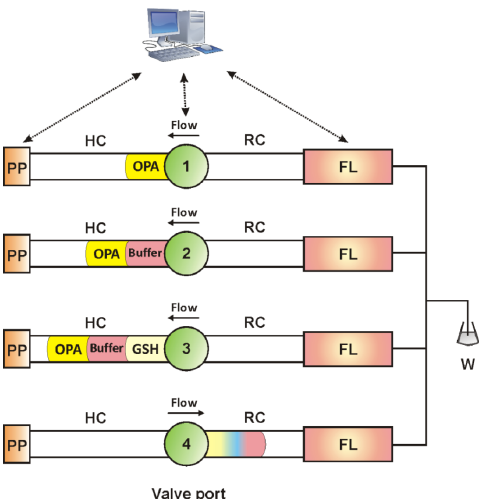
Figure 1. Zone fluidics (ZF) sequence and configuration: PP = pump, HC = holding coil, RC = reaction coil, FL = fluorimetric detector and W = waste (for experimental details, see Section